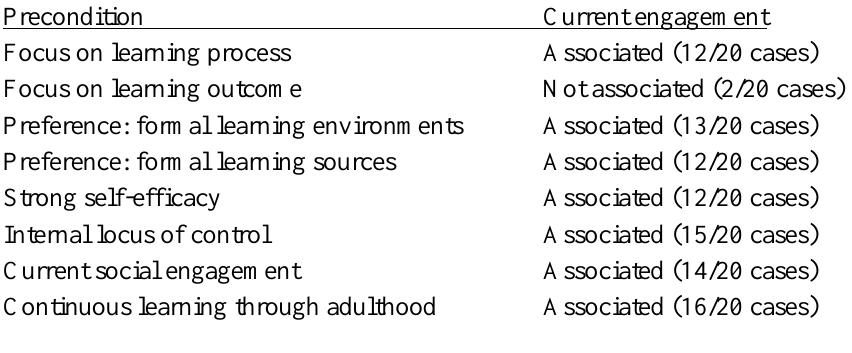
Relationships between Current Engagement in Learning Activities and Preconditions